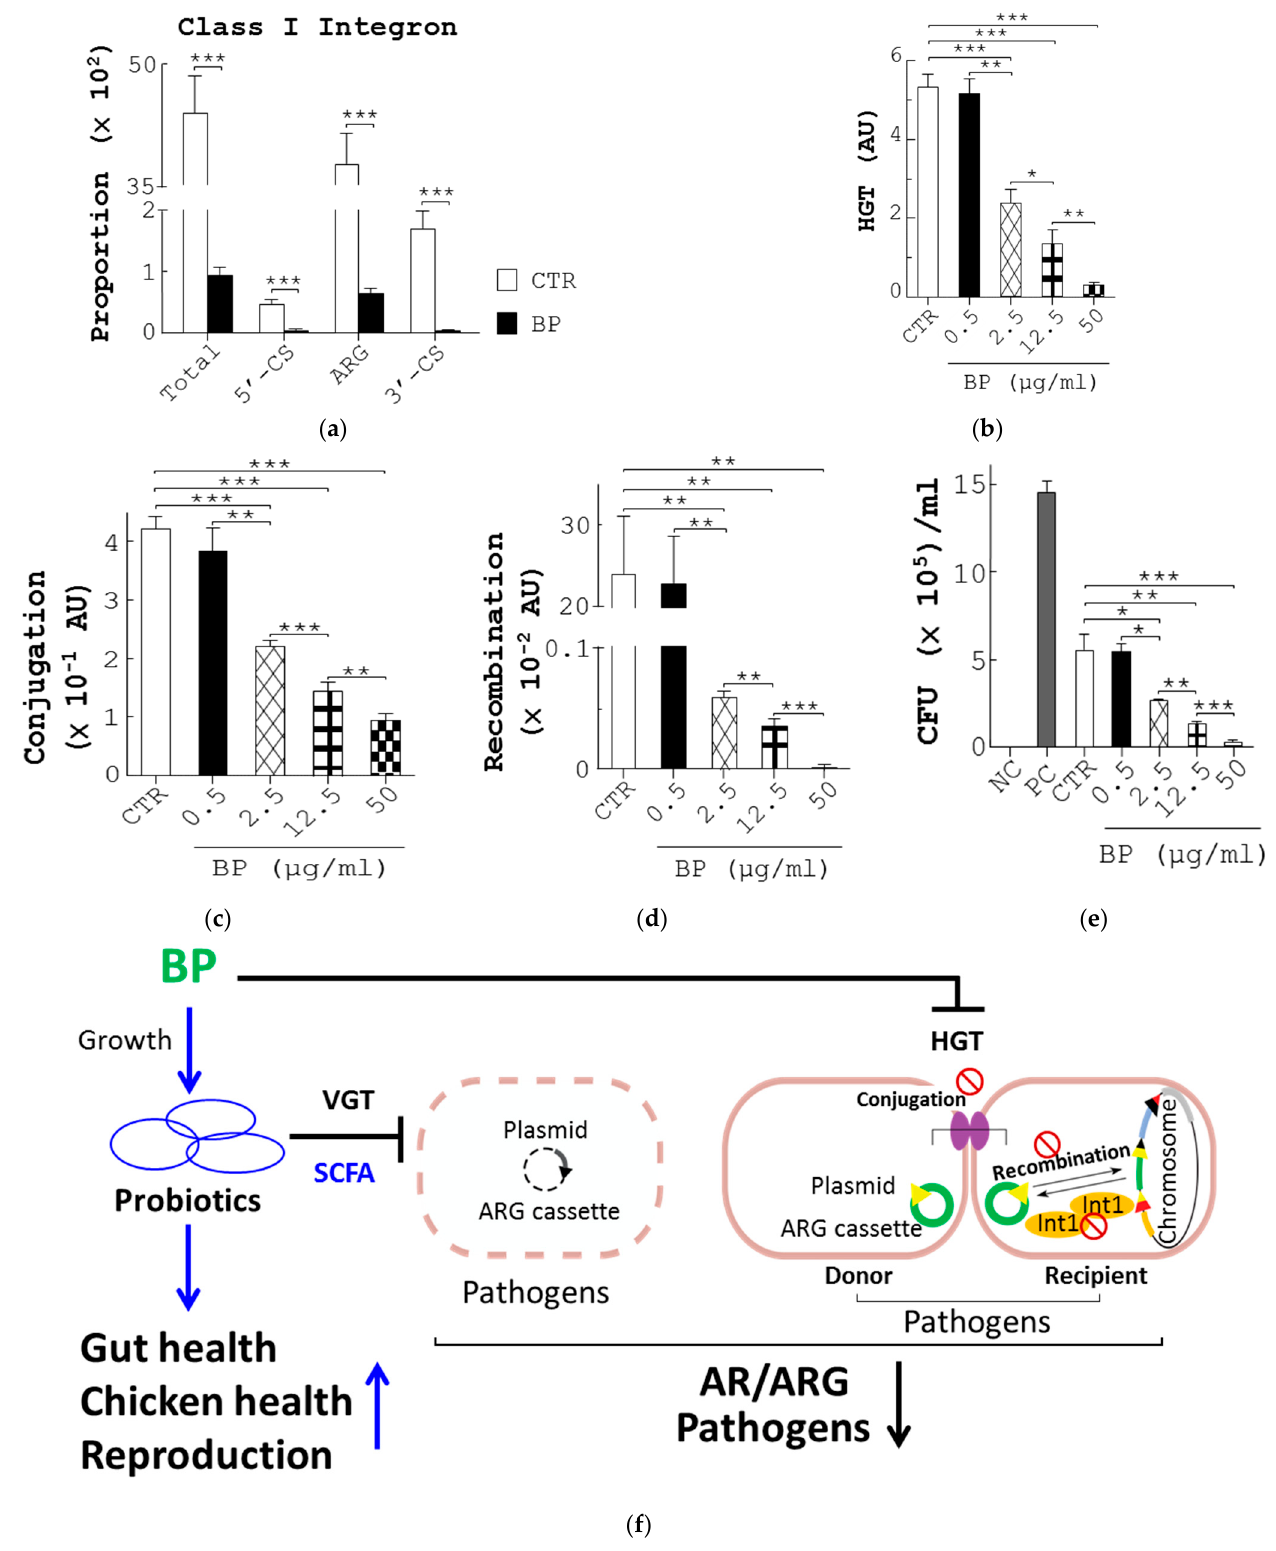
Figure 5. BP reduces the proportion of ARG in fecal bacteria as well as the frequency of bacterial conjugation and recombination. ( a ) The abundance of the class 1 integron (Total), comprising the 5 ′ -CS, ARG, and 3 ′ -CS, in fecal microbiota from control (CTR) and BP-fed hens (Figure 1e) was deter- mined using metagenomic NGS analysis. ( b ) The frequency (AU) of horizontal gene transmission (HGT) was evaluated in each group by mating pD042-harboring donors ( β 2163) with p3938 and p929-harboring recipients (UB5201) in the presence of 0.1% methanol (CTR) or BP at the indicated dosages. ( c ) The conjugation frequency (AU) was determined by mating RP4-harboring donors (BM21) with recipients (MG1656) in the presence of 0.1% methanol (CTR) or BP at the indicated dosages. ( d ) The recombination frequency (AU) was determined by transforming pD042 into recip- ients (UB5201) harboring p3938 and p929, followed by incubation in the presence of 0.1% methanol (CTR) or BP at the indicated dosages. ( e ) The inhibition of BP for integrase was analyzed using the Gateway system. One reaction in which pDONR221 and pEXP7-Tet were incubated in the absence (NC) and presence (PC) of integrase (Gateway clonase) were transformed into DH5 α . The other reactions in which pDONR221, attB -flanked amp R DNA, and integrase were incubated with 0.1% methanol (CTR) and BP at the indicated dosages were transformed into DH5 α . After overnight growth, the colonies were calculated. Data from 3 repeats are presented as the mean ± SD. One-way ANOVA tests were used for statistical analysis of differences between groups and p (*) < 0.05, p (**) < 0.01, and p (***) < 0.001 are considered statistically significant. ( f ) A scheme illustrating the mech- anism of BP for regulation of gut microbiota and beneficial outcomes in laying hens. On one hand, BP promotes probiotic growth and production of its antimicrobial metabolites (e.g., SCFA) and, in turn, promotes gut health, host health and reproductive performance. In addition, SCFA can kill pathogens and this killing reduces VGT of ARG in pathogens. On the other hand, BP also suppresses interbacterial HGT by reduction of conjugation and recombination and enzymatic inhibition of in- tegrase in pathogens. 4. Discussion Medicinal plants and their compounds improve health, growth, and/or reproduction in laying hens [35,36], broilers [37,38], and aged chickens [39]. However, little is known about the mechanisms by which plants/compounds modulate gut microbiota and enhance health and reproduction in animals [36,40,41]. This work demonstrated that BP amelio- rated host health, reproductive performance, and AR in aged laying hens by the Yin and Yang balance of gut microbiota, i.e., increasing probiotics and decreasing pathogens. Moreover, BP reduced AR due to inhibition of VGT and HGT of ARG in gut microbiota. BP improves growth performance and coccidiosis in 1-month-old broilers through manipulation of gut microbiota, including seven increased probiotic genera and five de- creased pathogenic genera [20]. The health and reproduction of aged hens declines over